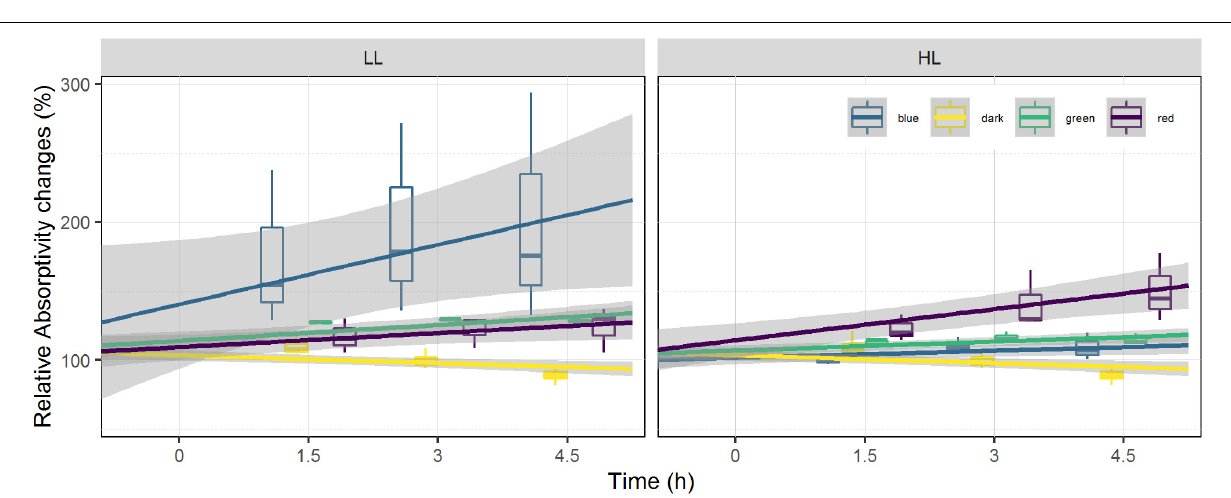
FIGURE 4 | Relative absorptivity changes at the surface of the sediment. Absorptivity is displayed as percentage of the initial value prior to illumination (at T0). It is used as a biomass proxy at the surface of the sediment. Each color has been fitted with a linear model where confidence interval (0.95) are represented in gray ( n =